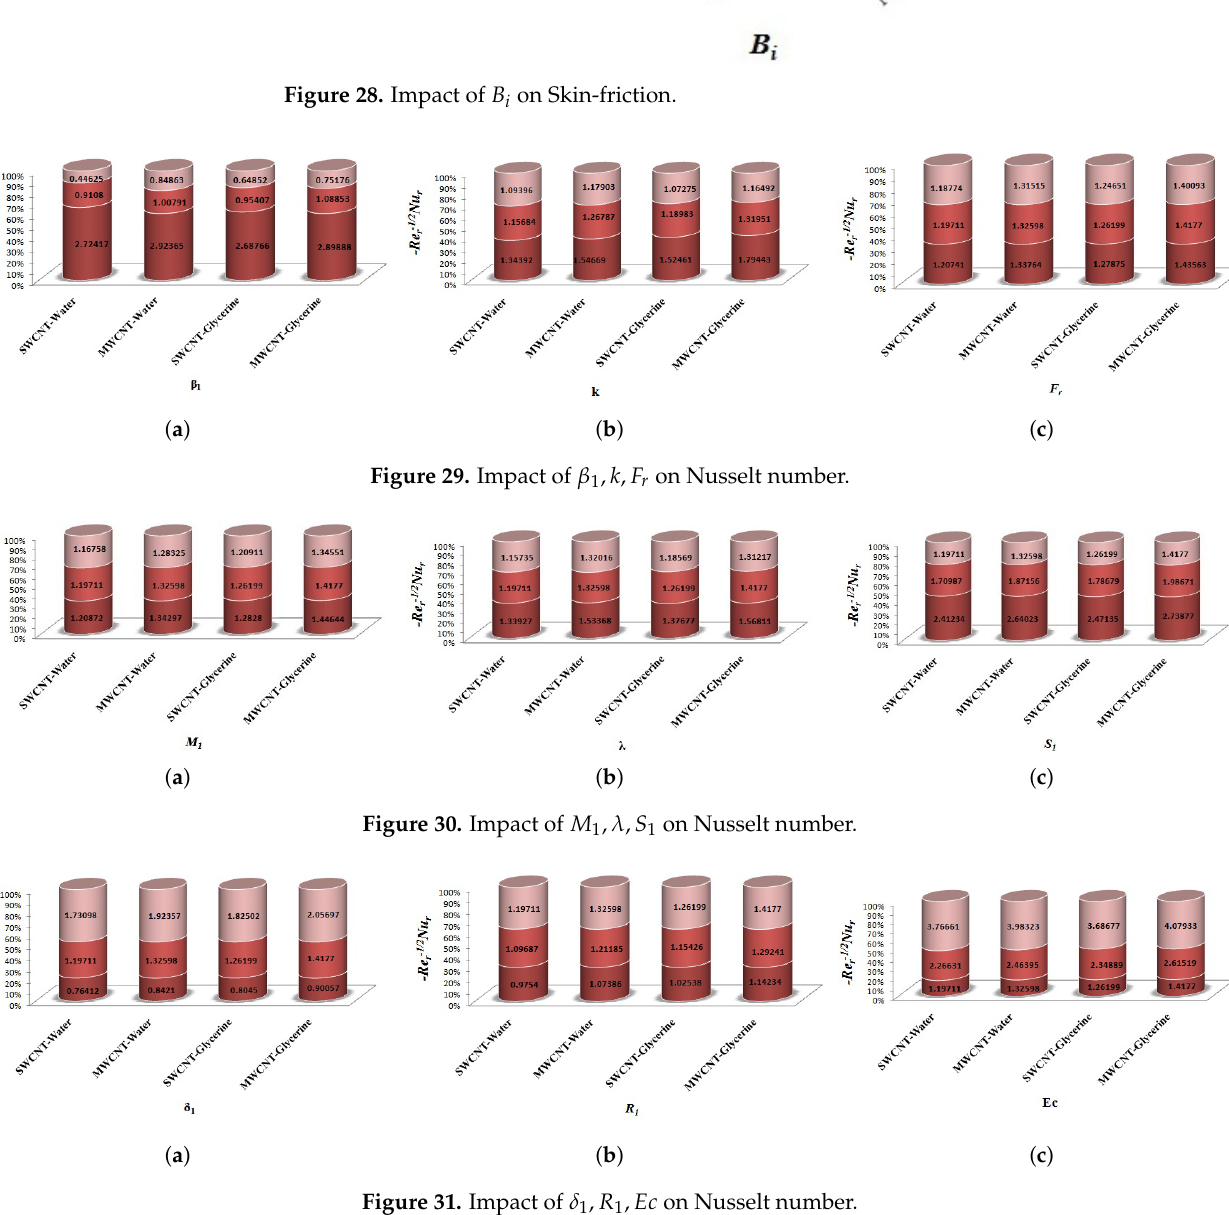
Figure 31. Impact of δ 1 , R 1 , Ec on Nusselt